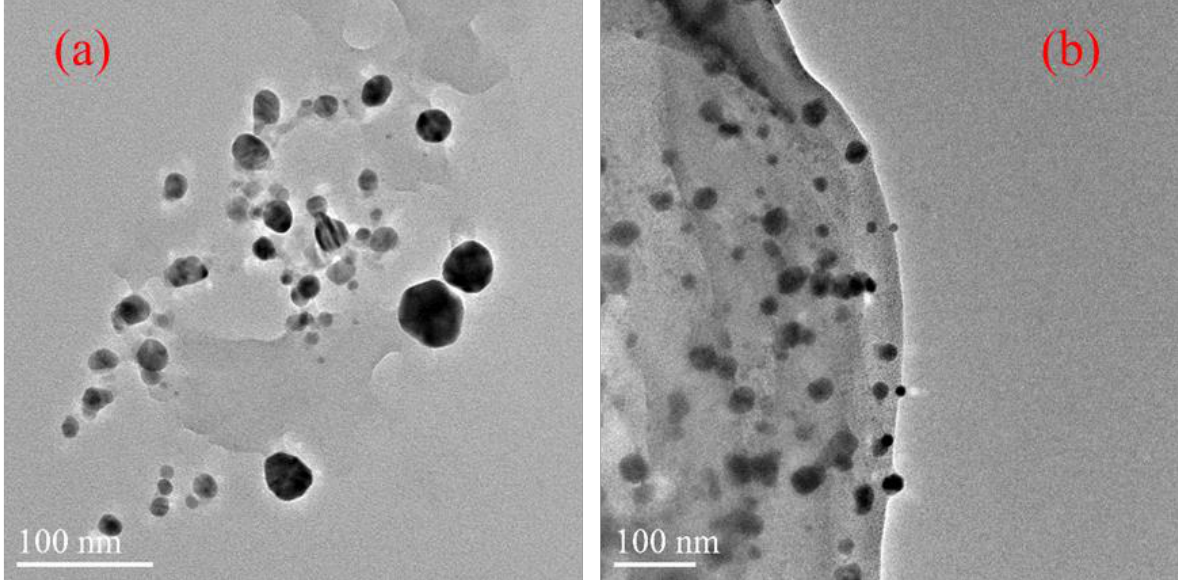
Figure 2. In HRTEM figure, ( a ) represents CuO – ZnO whereas ( b ) represents ZnO – CuO/g – C 3 N 4